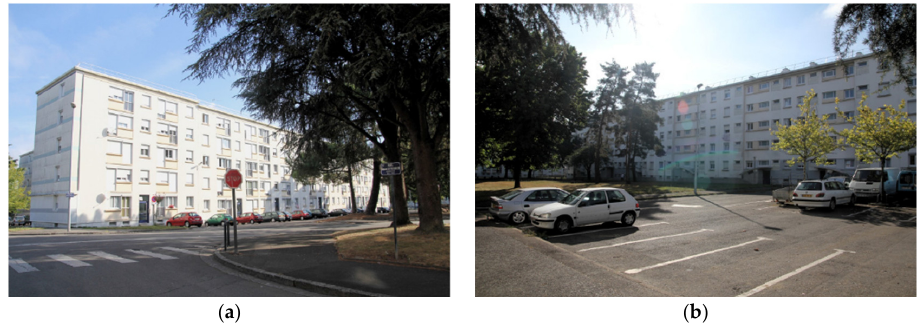
Figure 2. The Dunant building: ( a ) southern facade; and ( b ) northern facade.